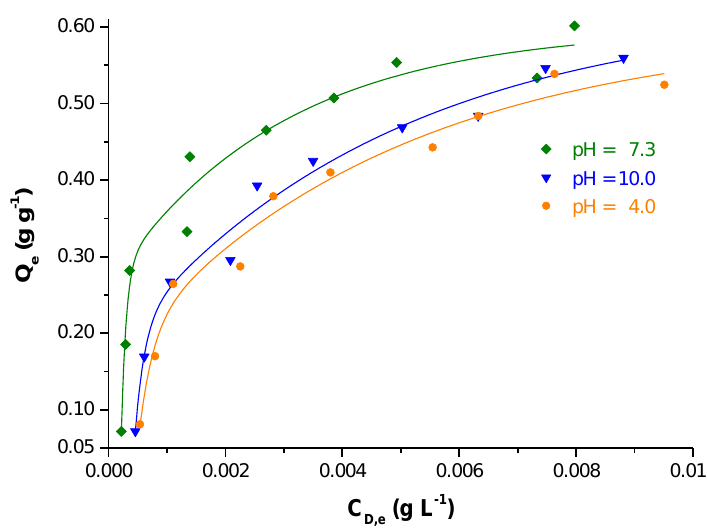
Figure 7. Experimental adsorption isotherms for BB 3 on potassium humate at various pH values (287 K).